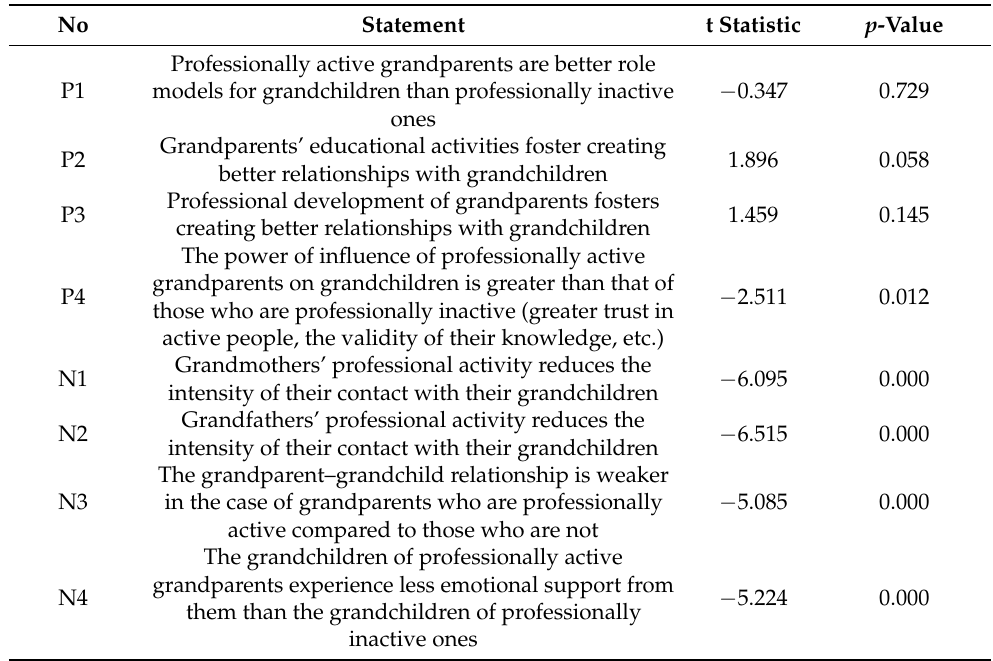
Table 2. Results of t -test for the grouping variable